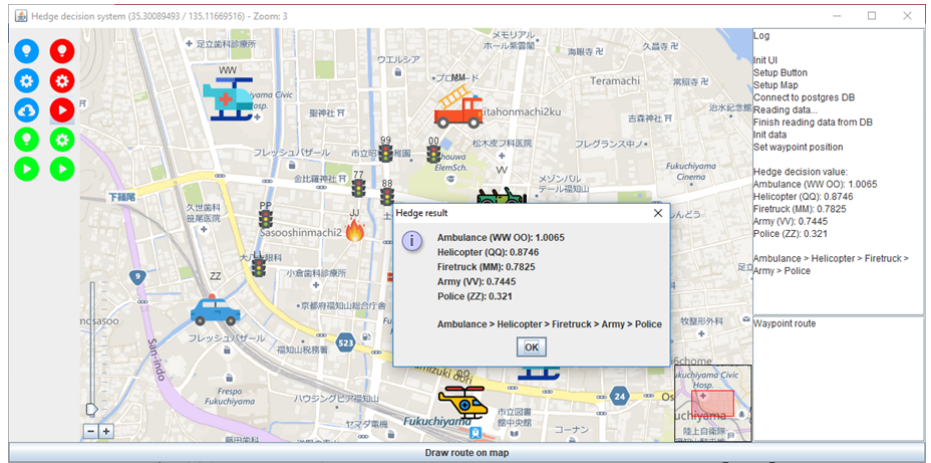
Figure 11. Priority vehicles in order to identify emergency locations in Japan on the Google map.